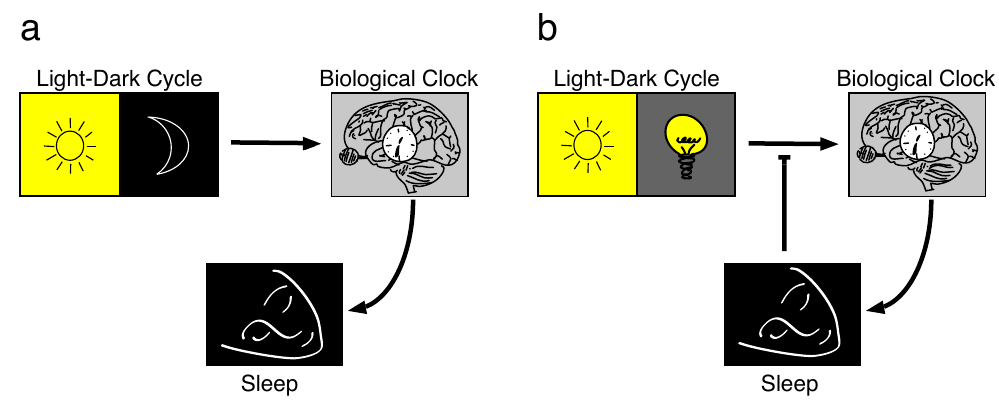
Figure 2. Di ff erences in light conditions for the Biological Clock in the pre-industrialized ( a ) and the industrialized ( b ) eras. Historically ( a ), it was the strong di ff erence between natural daylight and darkness that was perceived by the eyes and relayed to the central pacemaker in the suprachiasmatic nucleus (SCN). The SCN neurons entrain to this zeitgeber and transmit this information about day and night to the biological clocks in the rest of the body. Sleep is the major physiological behavior that is under the control of the biological clock interacting with the homeostatic component [67]. The light conditions of the industrialized / urban human environment (see text for details) have resulted in more or less constant light throughout the 24-h day ( b ), except for the time when we close our eyes during sleep. This situation can also be described as a short circuit between the inputs and the outputs of the circadian